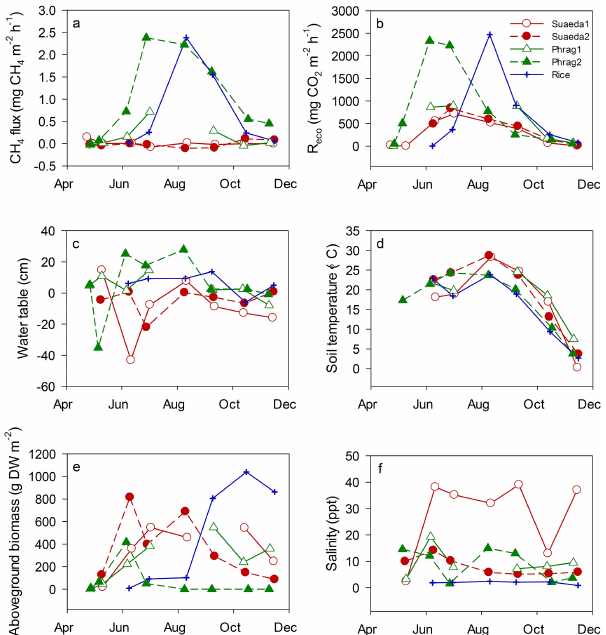
Figure 1. Seasonal variation in (a) CH 4 emission rates, (b) ecosys- tem respiration, (c) water table, (d) soil temperature, (e) above- ground dry biomass and (f) salinity in two Suaeda salsa wetlands, two Phragmites australis wetlands and one rice paddy during 2012 in the Liaohe Delta, Northeast China. Plotted values are the aver- ages for six plots at each site. Data from Phrag2 are missing in Au- gust because it was not possible to sample due to extreme flooding. Above-ground biomass data from Suaeda1 are missing in Septem- ber due to technical